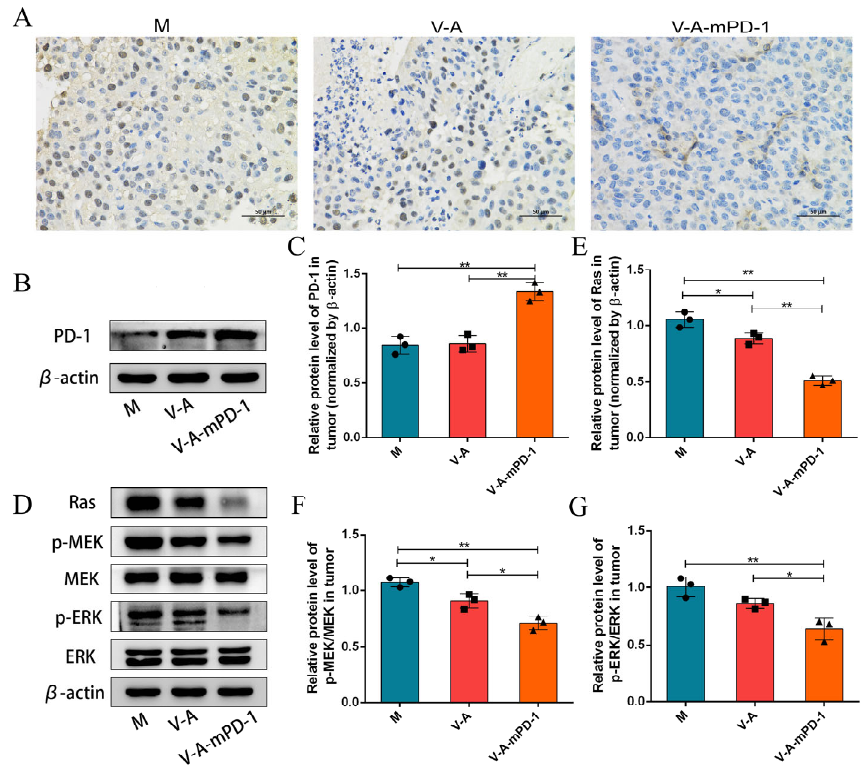
Figure 3 . Proliferation of murine melanoma tumors is clearly inhibited by colonization of tumors with the V-A-mPD-1 strain. ( A ) Immunohistochemical detection of PCNA level in tumor tissue (400 × ). ( B ) Western blotting analysis of PD-1 expression in tumor tissues. ( C ) Relative expression of PD-1 was quantified by ImageJ, and β -actin was used as an internal control. ( D ) Western blotting analysis of Ras, p-MEK, MEK, p-ERK, ERK expression in tumor tissues. The relative expressions of ( E ) Ras, ( F ) p-MEK/MEK, ( G ) p-ERK/ERK were quantified by ImageJ. β -actin was used as an internal control. One-way ANOVA and Tukey’s multiple comparison for C, E, F, and G. Data are presented as means ± SD ( n = 3). * p < 0.05, ** p <